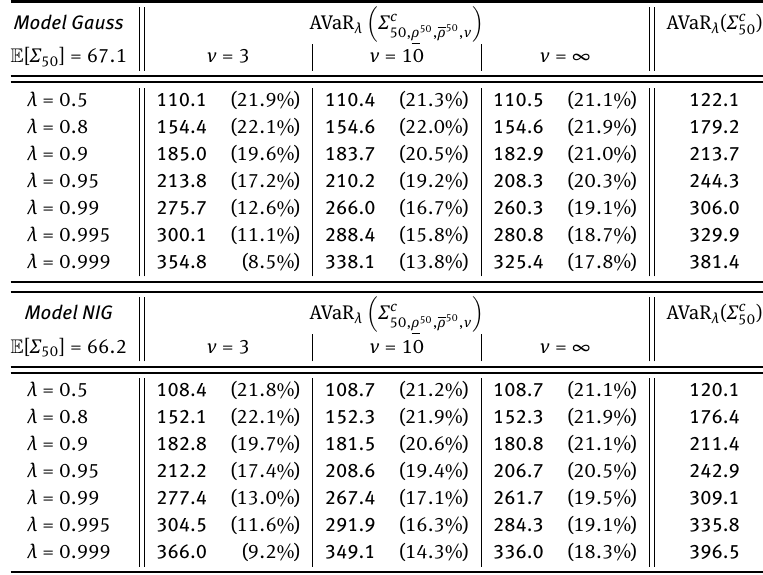
Table 4: Comparison of the improved risk bound AVaR λ ( Σ c AVaR ( Σ 50 ) in Model Gauss resp. NIG for T = 50 trading days for different levels λ , for different ν and for fixed ρ 50 = 0.7338 λ and ρ 50 = −0.4563 . The relative DU-improvement given by 1−(AVaR λ ( Σ c in